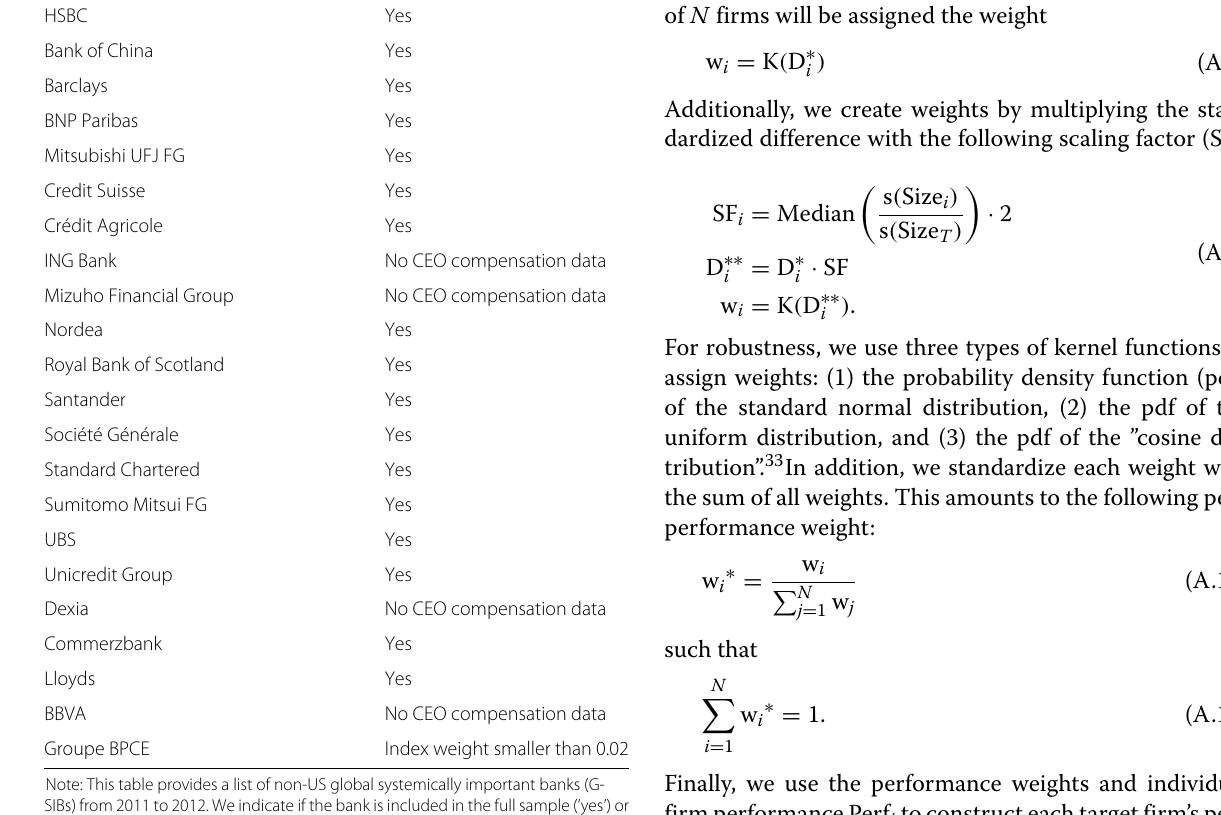
Included/reason for